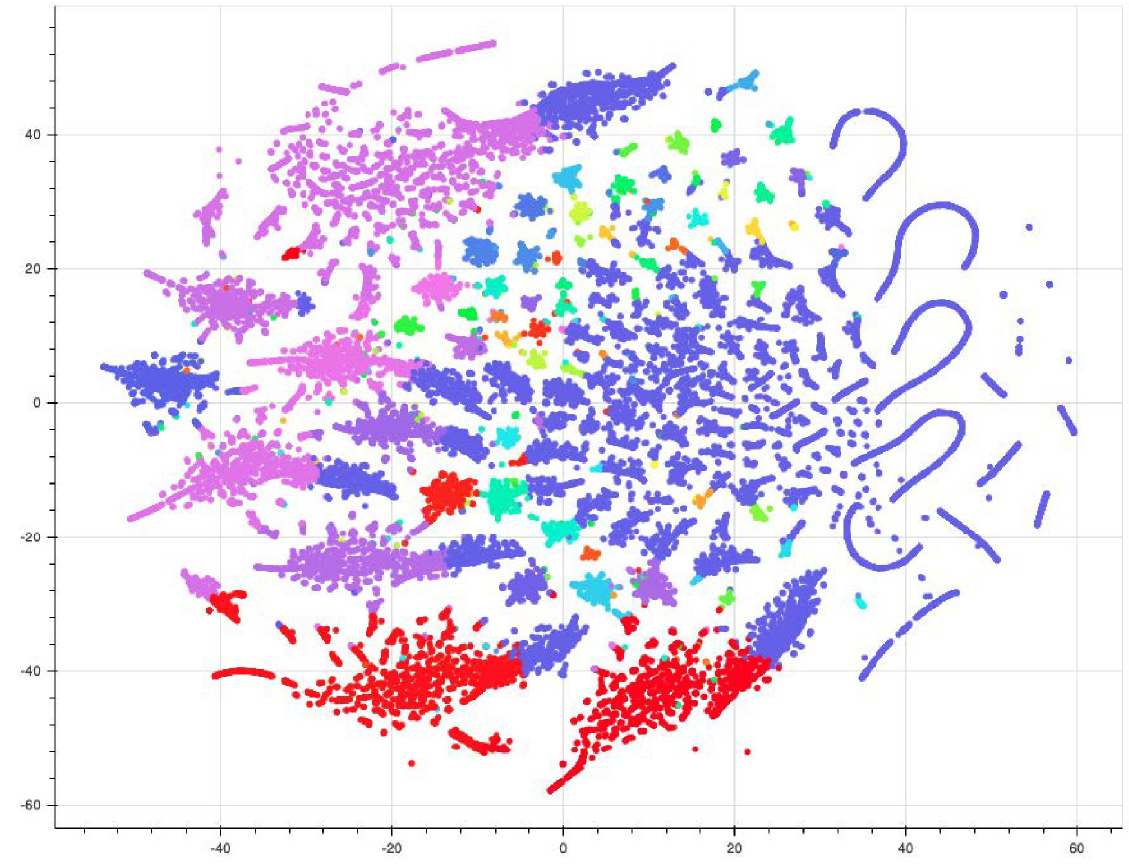
Fig 9. t-SNE clustering